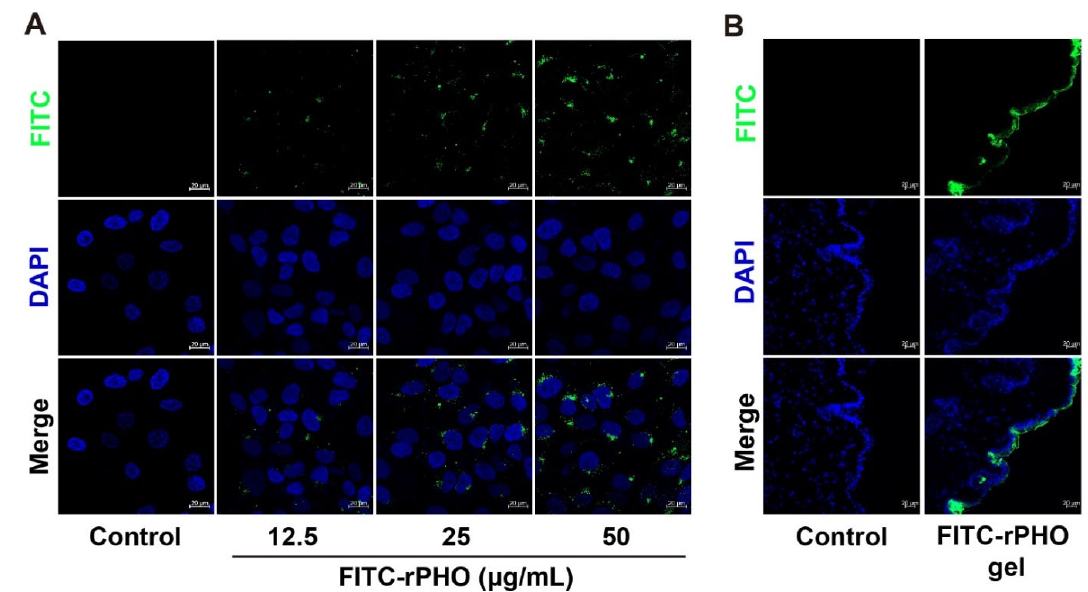
Figure 2. rPHO was taken up into cells and absorbed by the keratinocytes of the skin epidermis. ( A ) HaCaT cells were treated with different concentrations of rPHO-FITC. ( B ) FITC-labeled rPHO carbomer gels were applied to the dorsal skin for 24 h. Vertical skin sections with a thickness of 10 µ m were extracted with cryotome and observed under a fluorescence microscope for skin-associated fluorescence. Scale bar = 20 µ m.